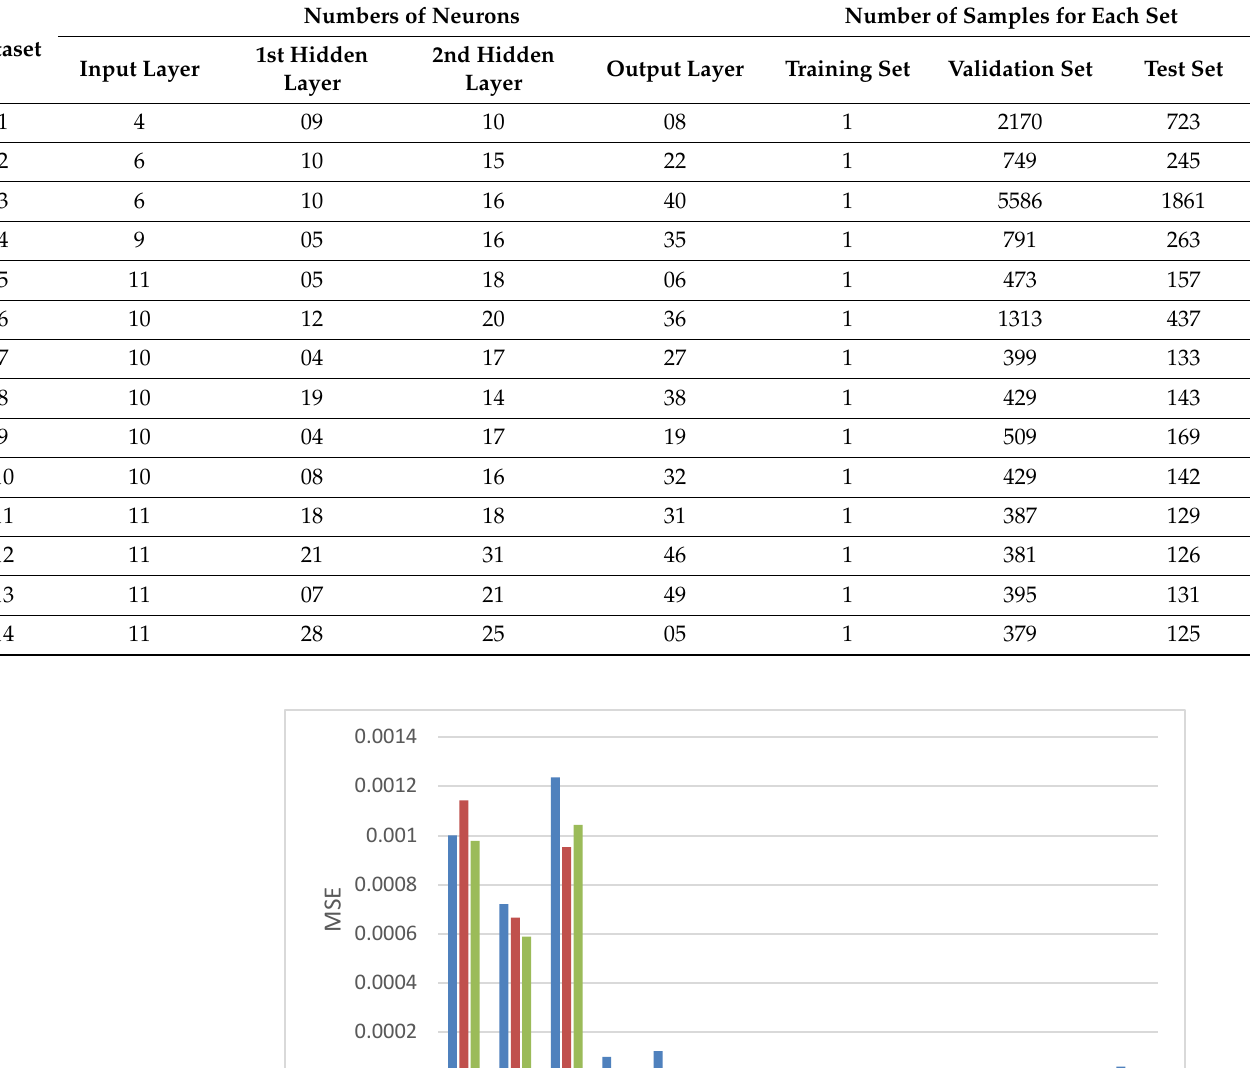
Table 9. Optimized parameters for the final model for three hidden layers.